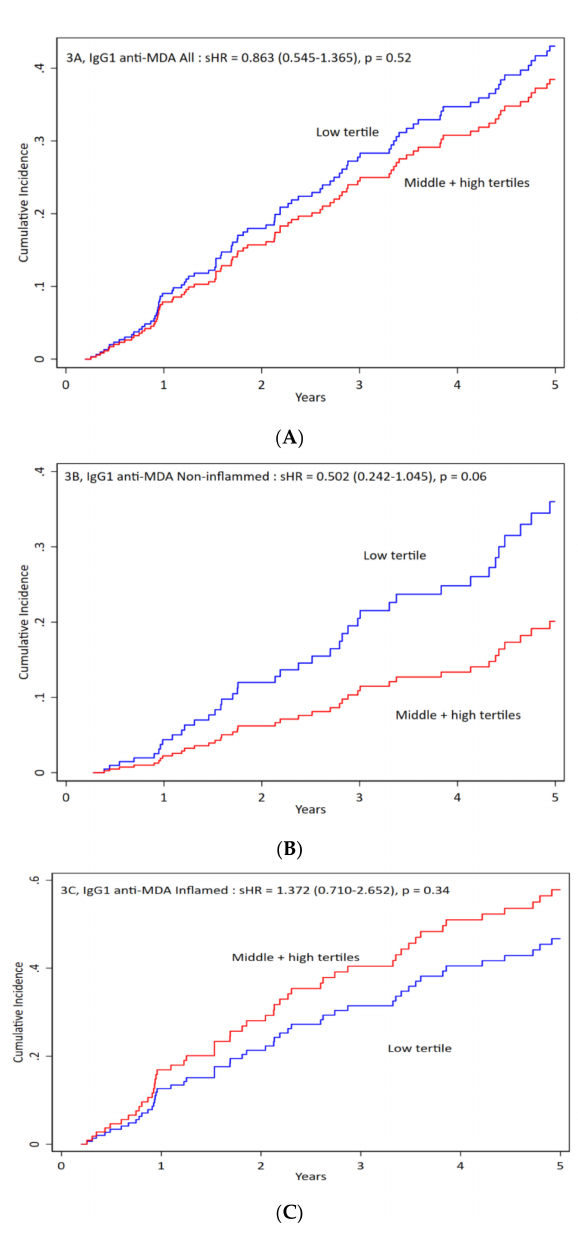
Figure 3. IgG1 anti-MDA impact on the mortality of all patients and inflamed versus non-inflamed. Patients were divided into three groups: ( A ) for all patients, ( B ) for non-inflamed patients, and ( C ) for inflamed patients. Antibody levels were divided into low vs. middle + high levels of IgG1 antibodies against malondialdehyde (anti-MDA) for cumulative incidence vs. time. For all patients the sHR is 0.863 (0.545–1.365), p = 0.52. For non-inflamed patients the sHR is 0.502 (0.242–0.1045), p = 0.06. For inflamed patients the sHR is 1.372 (0.710–2.652), p =